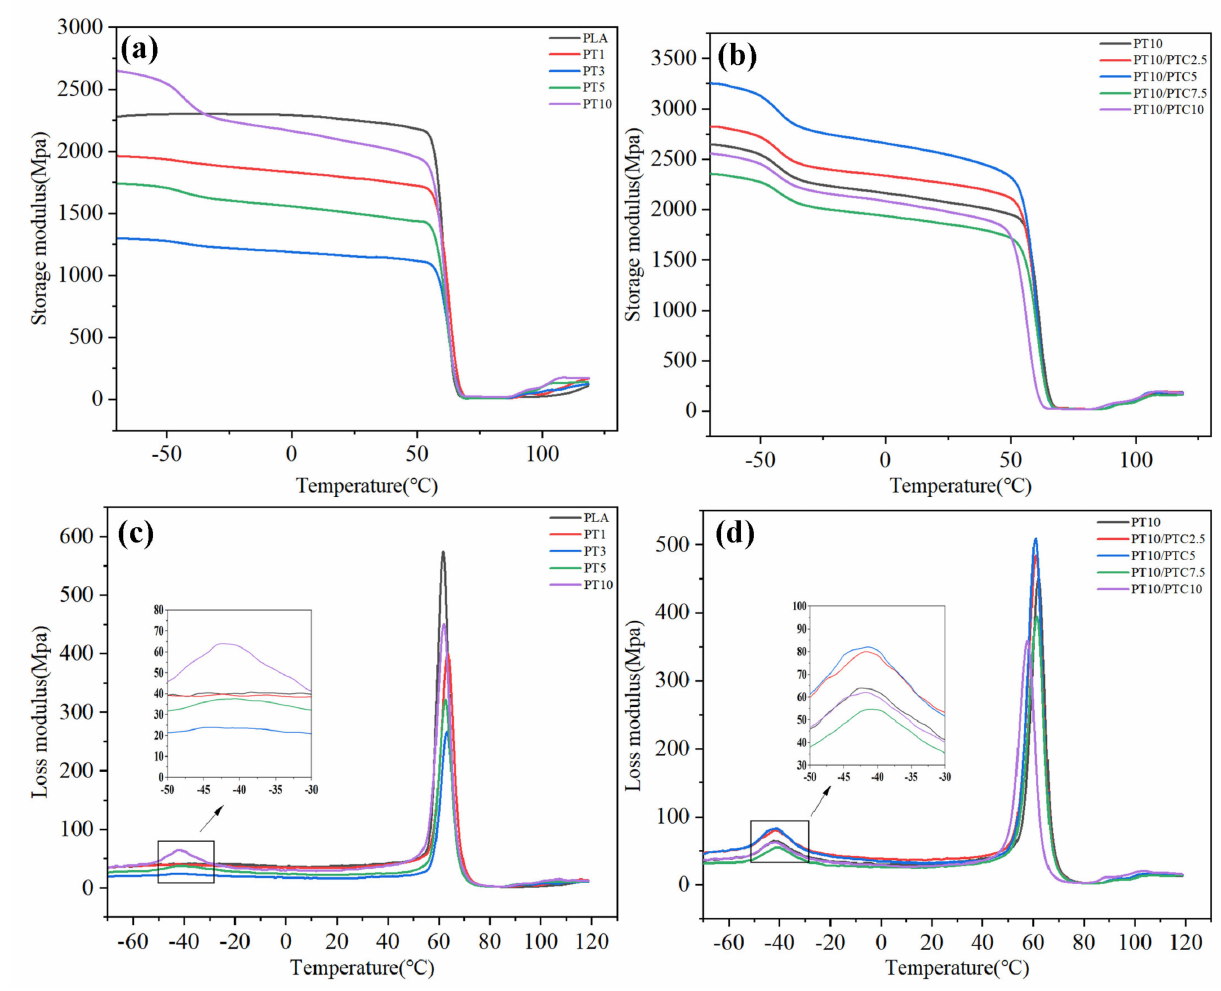
Figure 6. Storage modulus of ( a ) PLA/TPU and ( b ) PLA/TPU/PTC blends and loss modulus of ( c ) PLA/TPU and ( d ) PLA/TPU/PTC